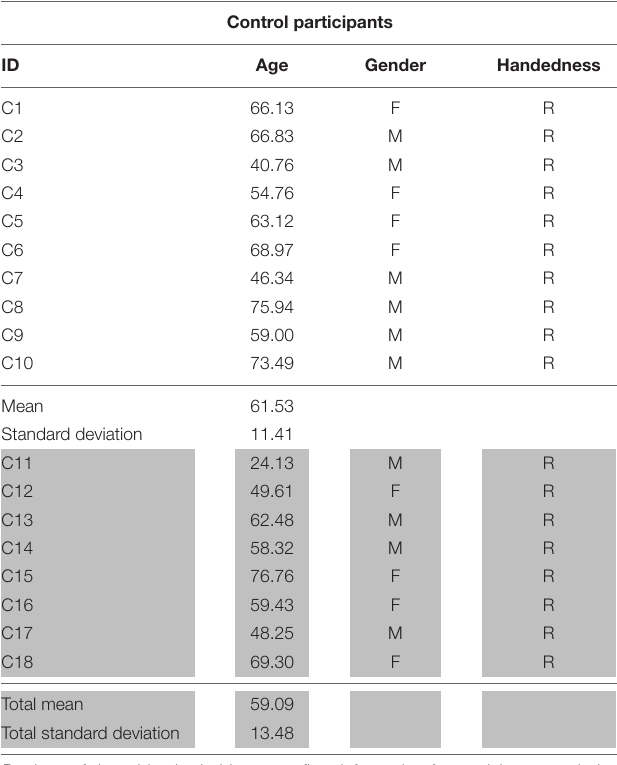
Portions of the table shaded in gray reflect information for participants excluded from the final analyses. Information for participants included in the final analyses is shown in white.